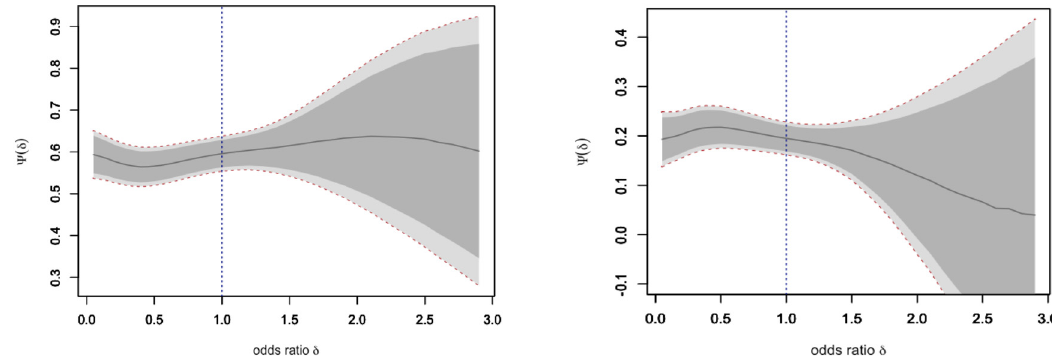
Figure 3: Estimated incremental e ff ect curves which represent the probability of having a live birth ( Left ) and a pregnancy loss ( Right ) . Lighter grey area with red dotted line represents 95% uniform bands and darker grey area represents 95% pointwise